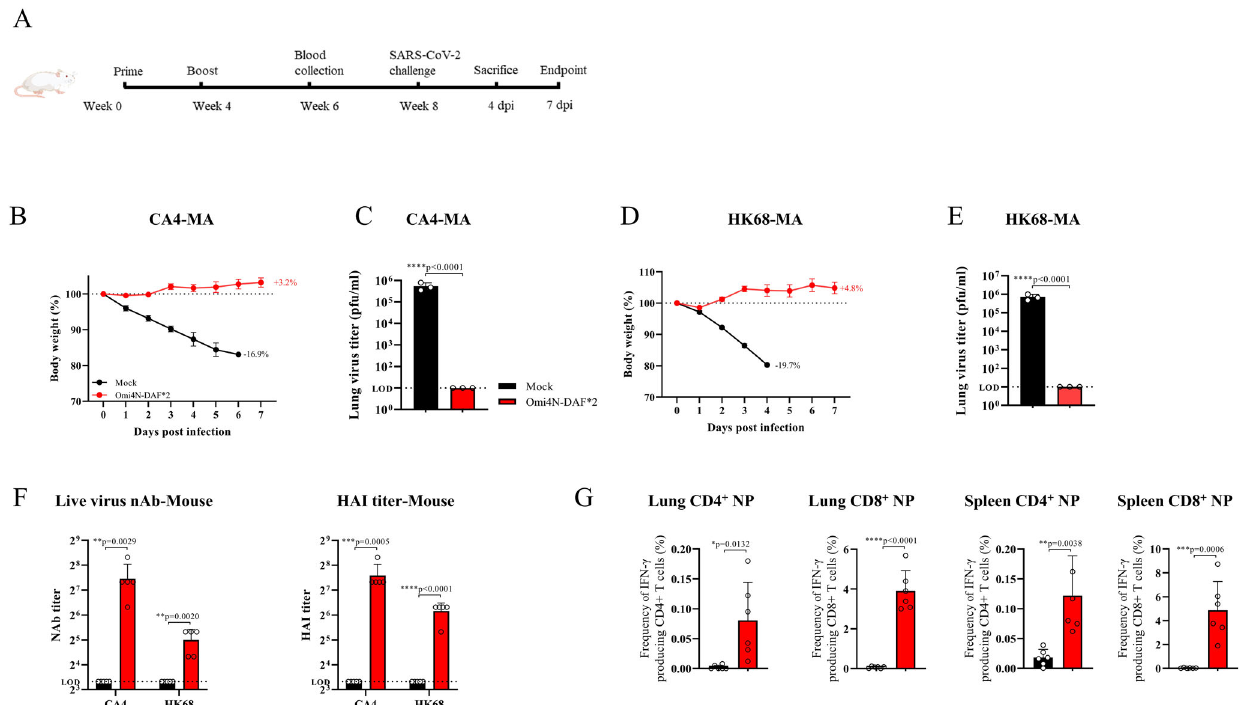
Fig. 6 | Protection against in fl uenza virus challenge in mice prime-boost immunized with DelNS1-RBD4N-DAF LAIV. A Illustration of schedule of immu- nization, blood collection and in fl uenza virus challenge for BALB/c mice. BALB/c micewereintranasallyprime-boostvaccinatedwithOmi4N-DAF(2×10 6 pfu)orPBS ( n =6 for each group), and then challenged with mouse-adapted in fl uenza virus strains matching the in fl uenza subtype of vaccines (CA4-) (H1N1, 5×10 3 pfu) or HK68-MA (H3N2, 1×10 4 pfu) ( n =3 for each group)) 4 weeks after boost immuni- zation. Body weight changes in mice following in fl uenza virus challenge were tracked( n =6foreachgroup)untilthecontrolgroupreachedthebodyweightloss cut-off (20%) for euthanization, in accordance with animal ethics protocols ( B , D ). Virus titers in the lungs were measured at 4 dpi ( C , E ). F BALB/c mice were prime- boost immunized intranasally with 2×10 6 pfu of Omi4N-DAF or PBS (mock) ( n = 5 for each group). Sera were collected 14 days after the second immunization for testing of neutralization titers and hemagglutination inhibition (HAI) titers against